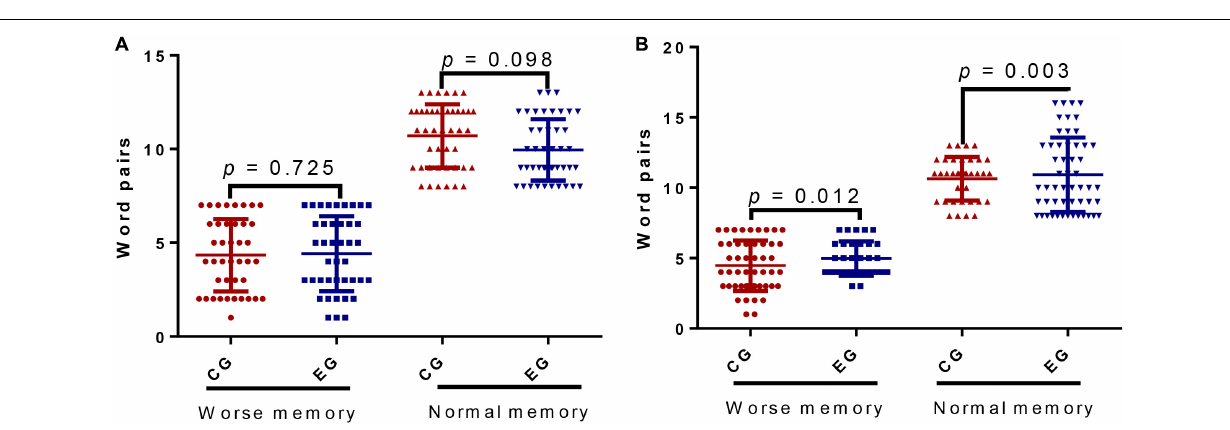
FIGURE 2 | The memory for word pairs between the control group (CG) and the ESB exercise group (EG). (A) Before intervention. (B) After 12-week intervention. Pair words ≤ 7 was regarded worse memory and pair words > 7 was designed as normal memory. n = 85 for each group and the statistical difference was significant if p <